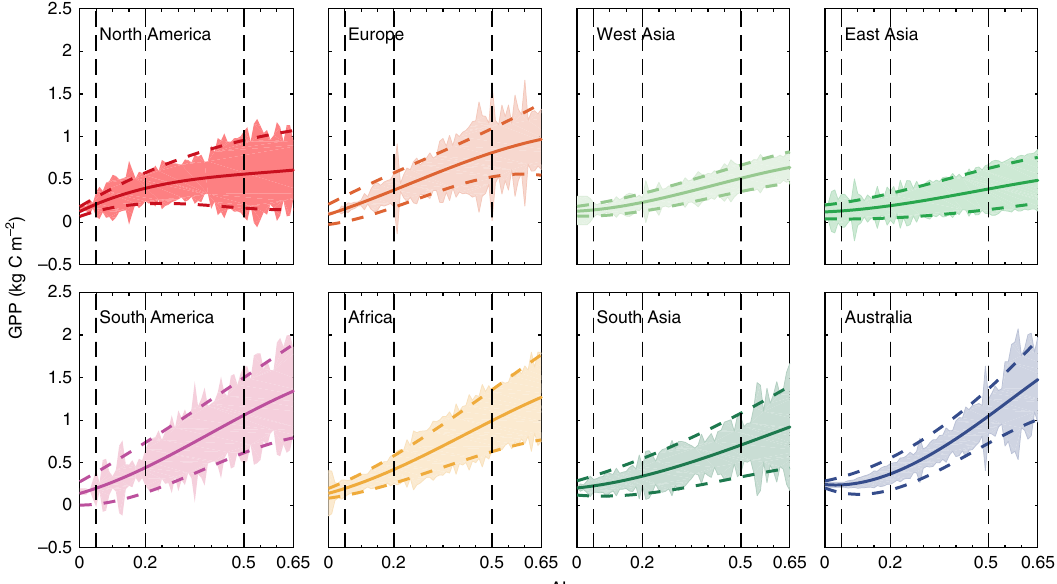
Fig. 4 Relationships of GPP to AI in the eight regions (2000 – 2014). The solid curves denote the fi tted relations between gross primary production (GPP) and aridity index (AI) in the eight dryland regions, and the upper and lower dashed curves denote the 95% con fi dence intervals of the fi tted relations. The shaded areas denote one standard deviation. The vertical dashed lines delineate the boundaries between the four dryland